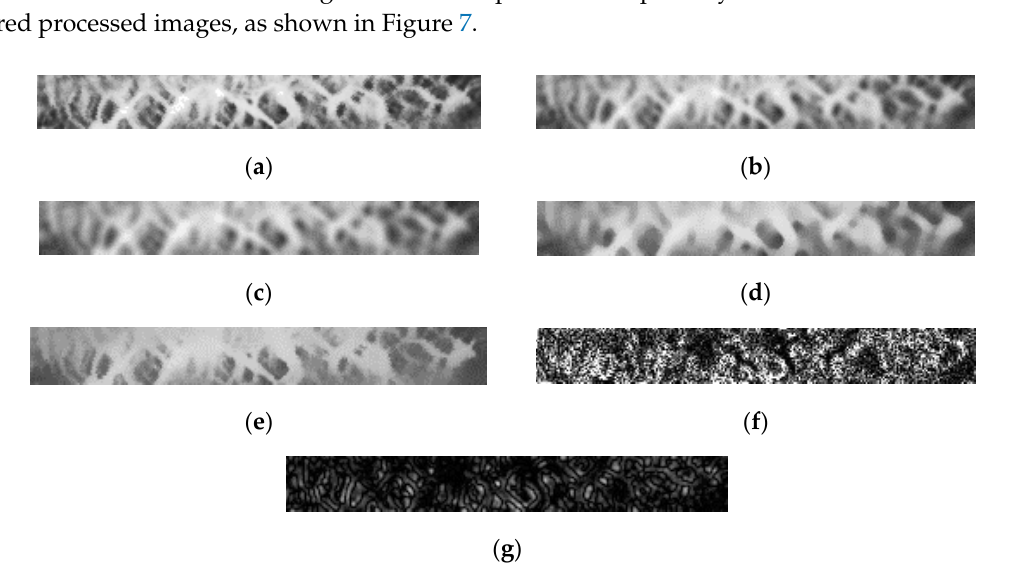
( f ) Figure 8. Six feature difference images: ( a ) Gaussian filter; ( b ) Square filter; ( c ) Median filter; ( d ) Bilateral filter; ( e ) Equalization histogram; ( f ) Laplacian of Gaussian. All points where the gray values are bigger than 0 in the six feature difference images are taken as feature points, and the feature points’ gray values of the original image are mapped onto a 256 × 32-dimensional image. The gray value of the non-feature points is set to 0. Finally, a stable feature recognition area can be obtained. The example of stable feature recognition areas between a group of the same category and different category is shown in Figure 9.